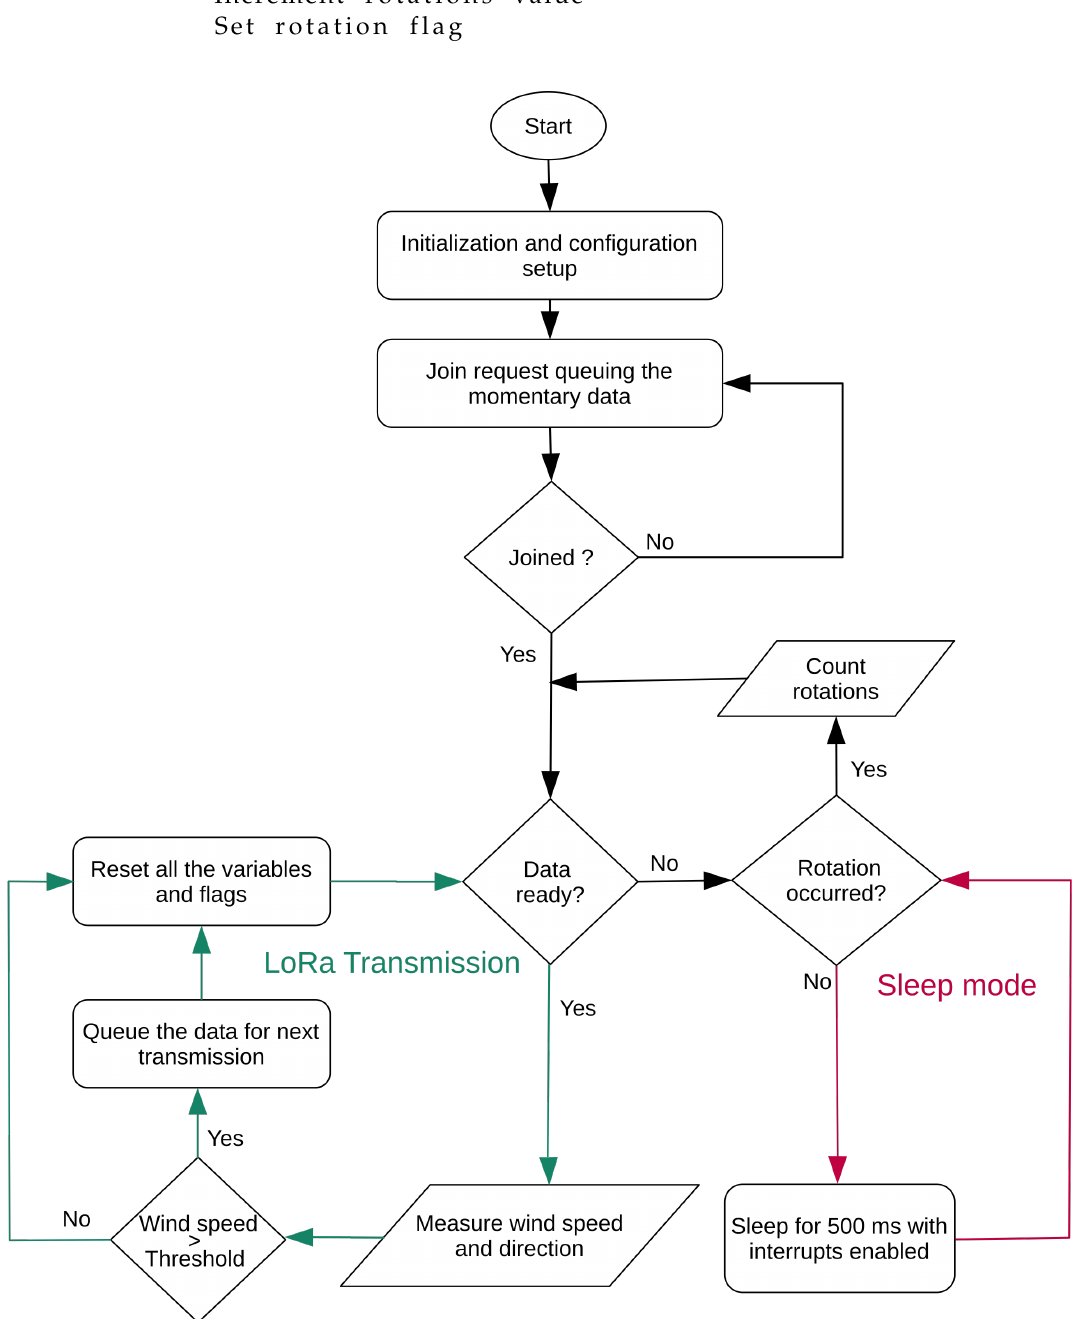
Figure 5. Asynchronous optimization algorithm for wind data collection. In our framework, the optimization of energy consumption is achieved by using the low power operation and the proposed asynchronous optimization algorithm. The main functionality of the algorithm is to compare the collected weather parameter and trigger transmission only when it is greater than the threshold. This kind of transmission is asynchronous and not based on any time period; hence, it can be adapted to other weather parameters which are random by nature. In the next section, the energy perspective of the weather station is